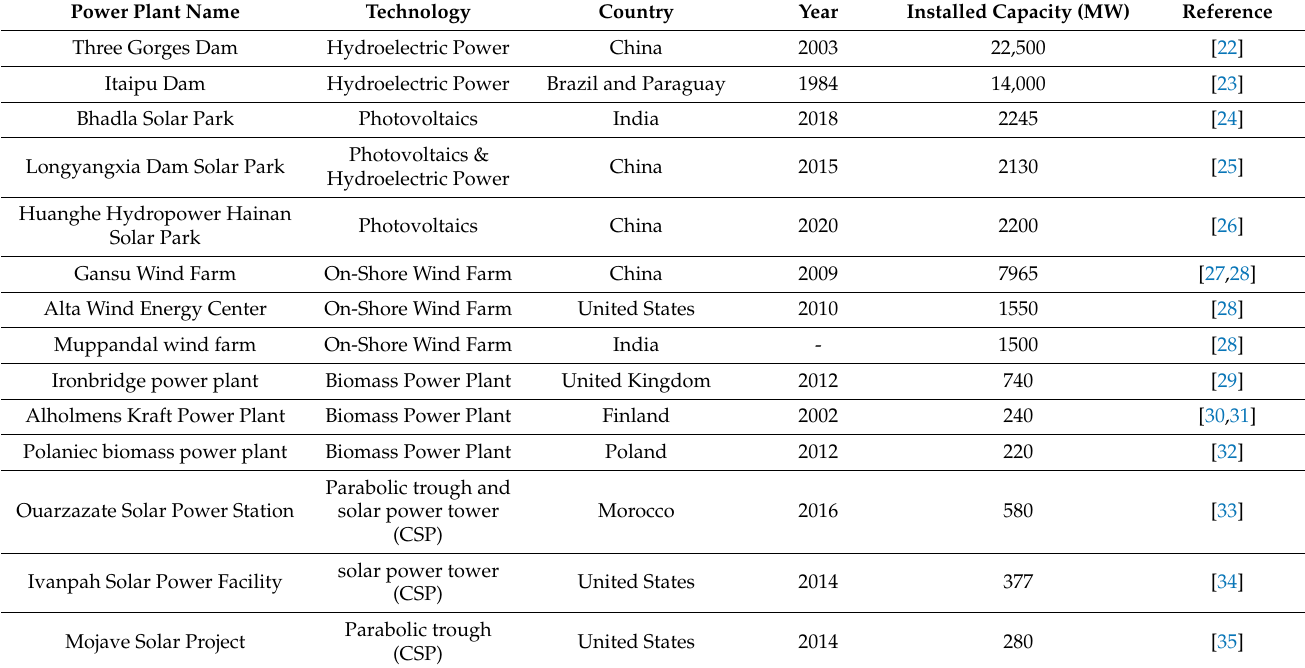
Table 1. Examples of the largest renewable energy projects of different technologies around the